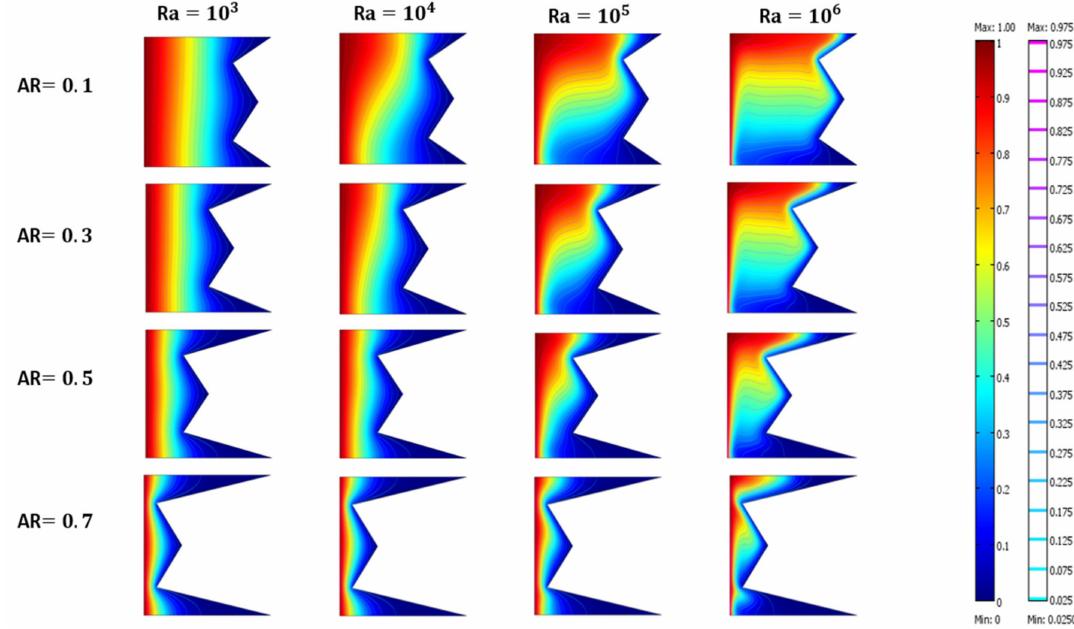
Figure 14. Isotherms for di ff erent values of aspect ratio (AR = 0.1, 0.3, 0.5 and 0.7) and Rayleigh number (Ra = 10 3 , 10 4 , 10 5 and 10 6 ) with Ha = 15, Da = 10 − 2 , ω = 0 and q ∗ =